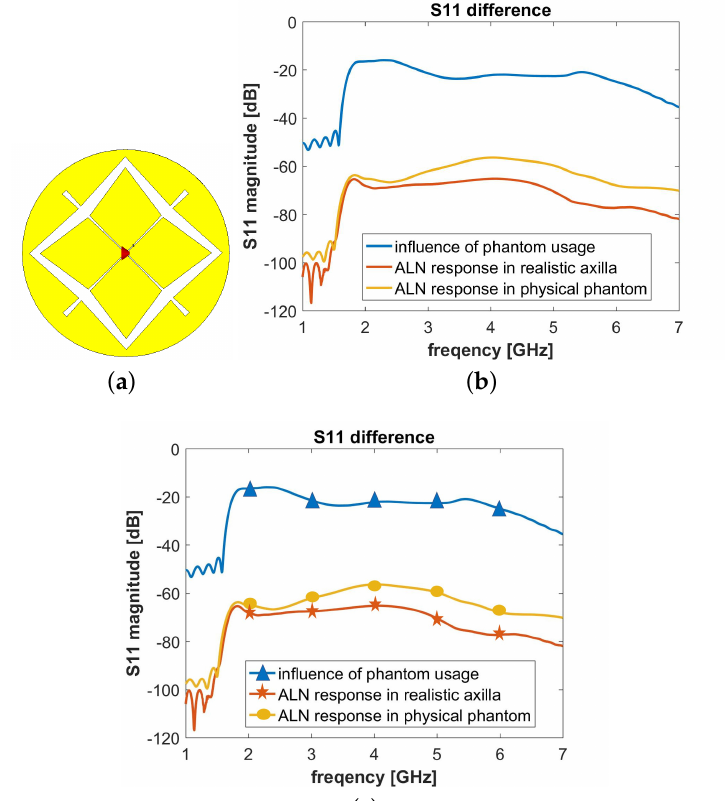
Figure 10. ( a ) Schematic of the crossed Exponentially Tapered Slot (XETS) antenna. ( b ),( c ) Influence of the usage of the developed phantom on the reflection coefficient ( S 11 ). ( b ) Comparison between the S 11 magnitudes measured by the XETS when stimulating the realistic axillary region and the developed physical phantom ; the S 11 of the antenna in free-space is also reported. ( c ) Magnitudes of the difference between the S 11 measured in three different pair of cases (see